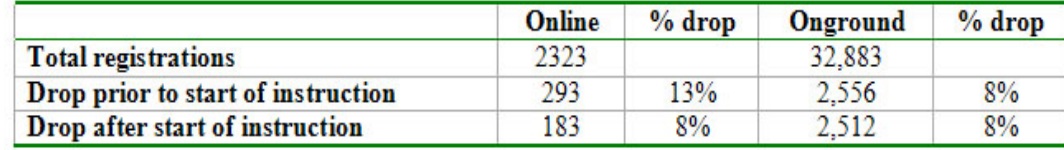
Table 6 . Drop rates before and after start of